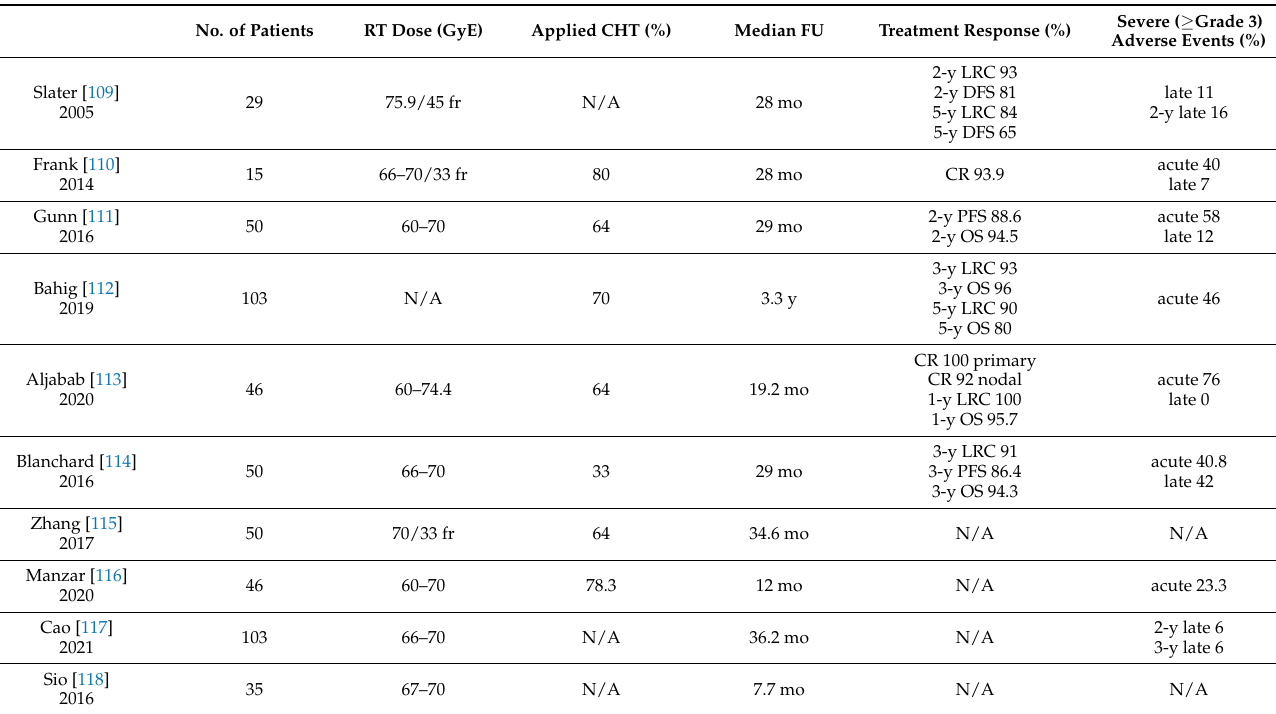
Table 2. Proton-based RT in the treatment of HPV+ OPSCC.